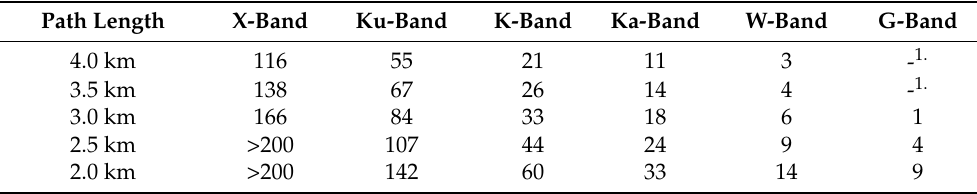
Table 5. Rain rates [mm h − 1 ] of constant rain rate precipitation shafts that extinguish the return signal for different path lengths and for radar X-, Ku-, K-, Ka-, W-, and G-bands. Calculations based on 40 dB radar receiver dynamic range with maximum SNR observed at 500 m. Simulation parameters mimic W-band WACR as deployed in GoAmazon and include atmospheric gas attenuation in the ITU reference